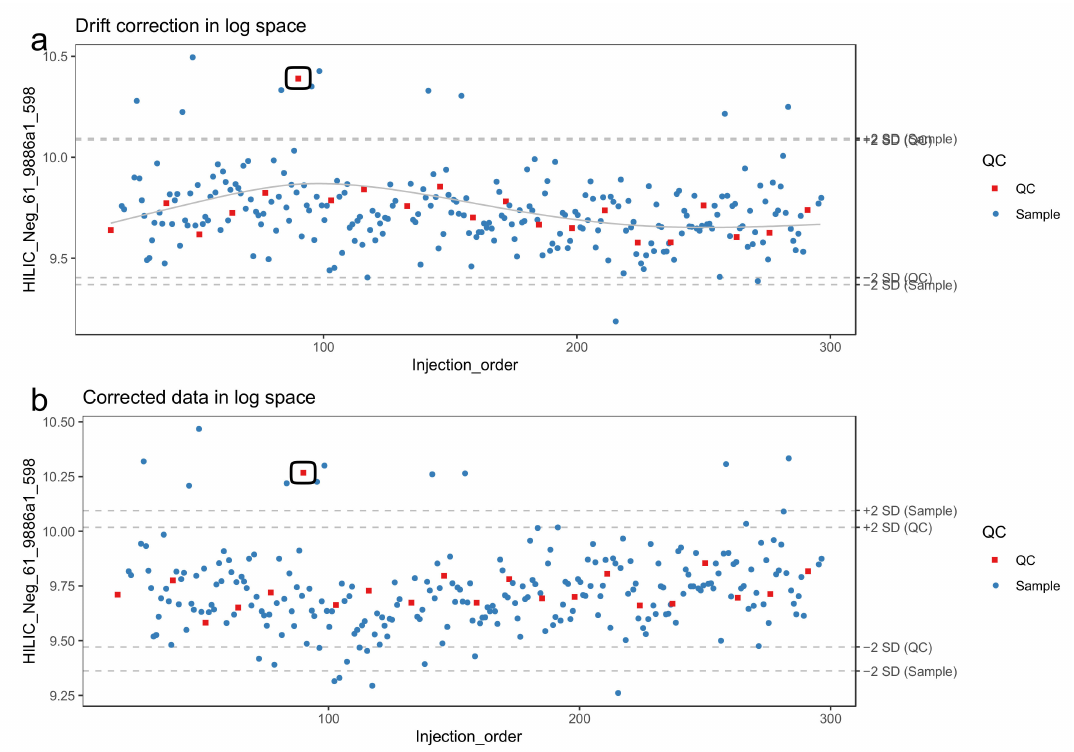
Figure 4. A molecular feature in the presence of an outlying quality control (QC) sample (circled) before ( a ) and after ( b ) drift correction by smoothed cubic spline regression. The horizontal lines represent 2 standard deviations from the mean of QC samples and biological samples, respectively. Due to the smoothing, the correction method is robust against the deviating QC sample and adjusts seemingly adequately for the global drift